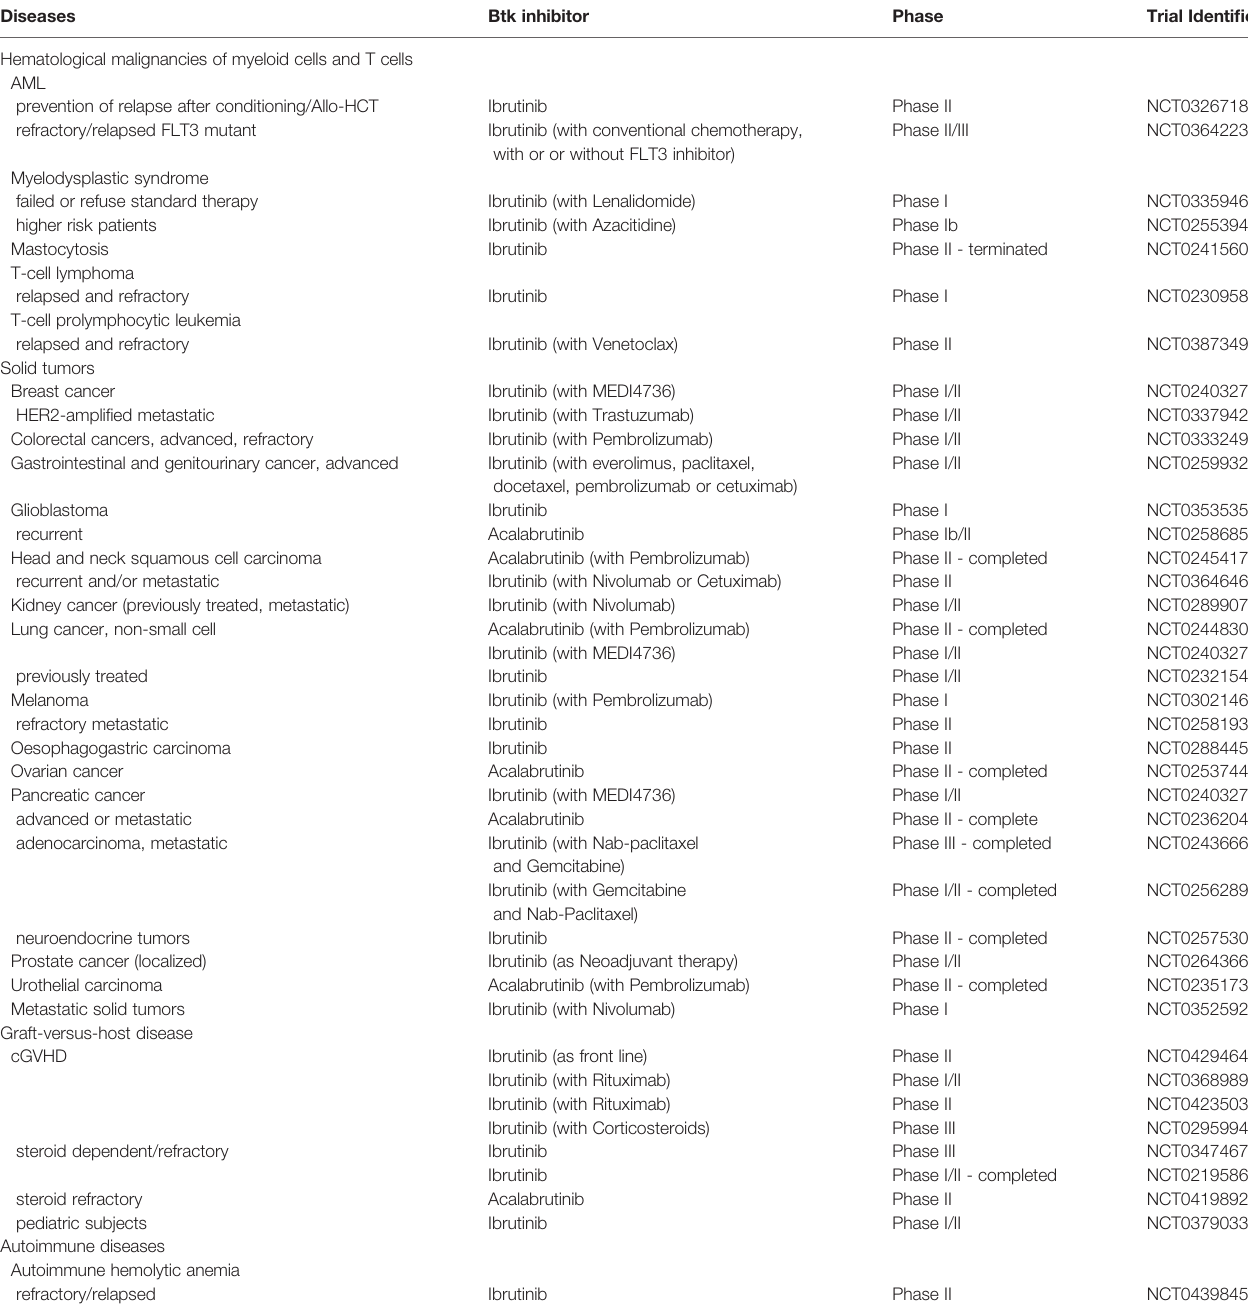
TABLE 1 | Clinical trials of BTK inhibitors in human diseases beyond B cell malignancies that are currently registered at ClinicalTrials.gov. Diseases Hematological malignancies of myeloid cells and T cells AML prevention of relapse after